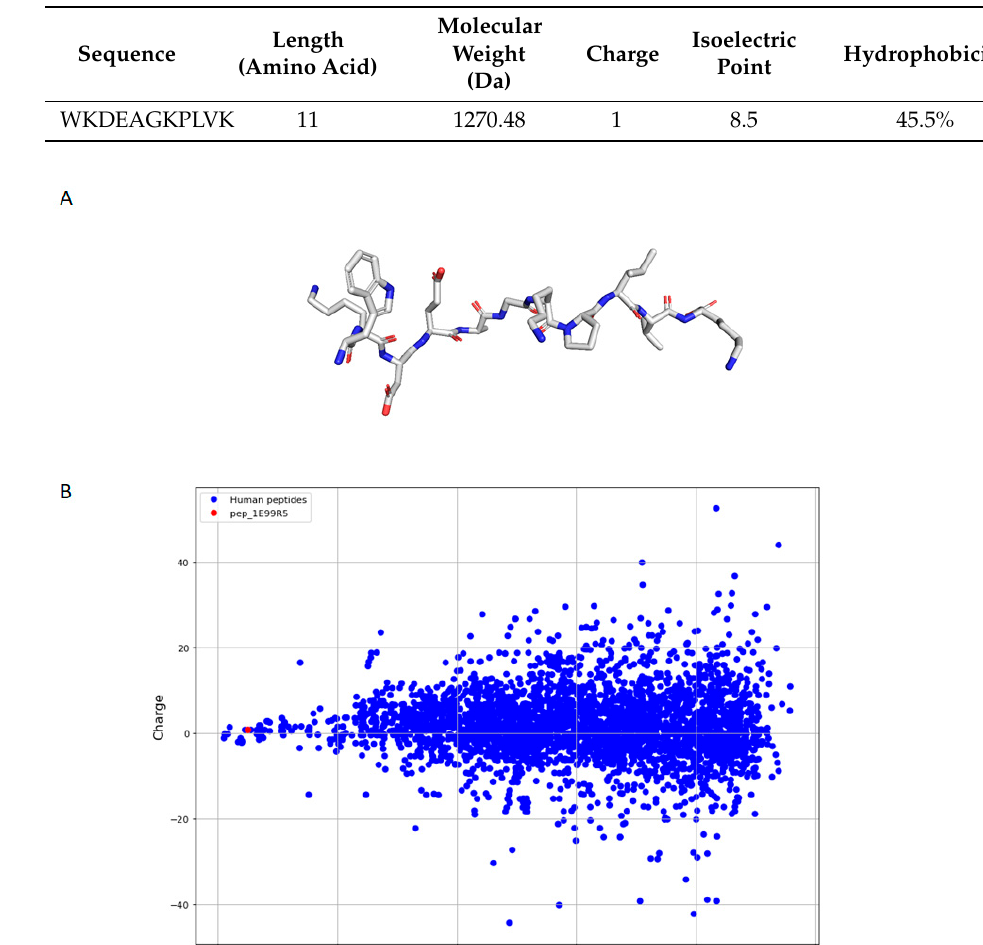
Table 1. pep_1E99R5 characteristics.